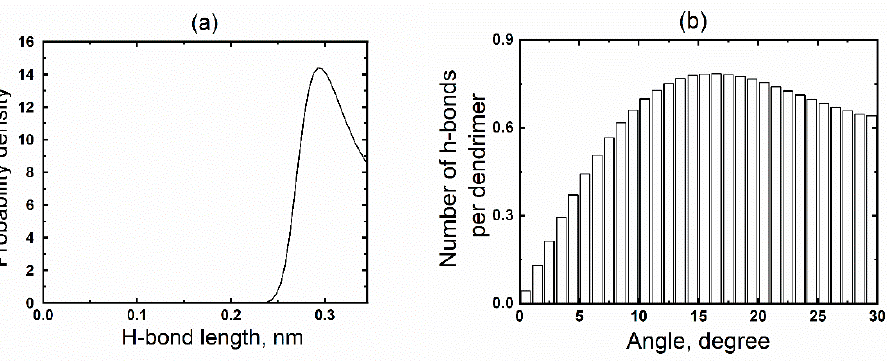
Figure 6. The hydrogen bond length ( a ) and angle ( b ) distributions in PAMAM G2 dendrimers in the melt.